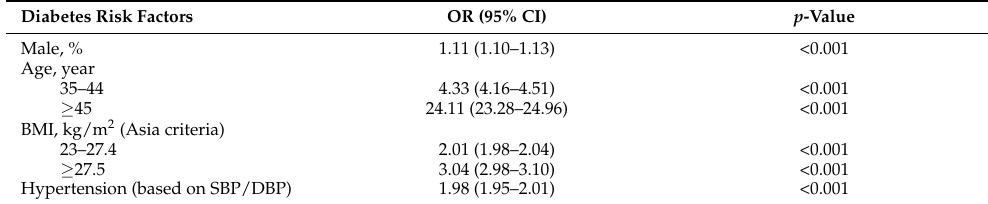
Table 4. Korean adults’ diabetes Score in the Korean diabetes dataset (96,512 diabetes cases, n = 837,174, AUC =